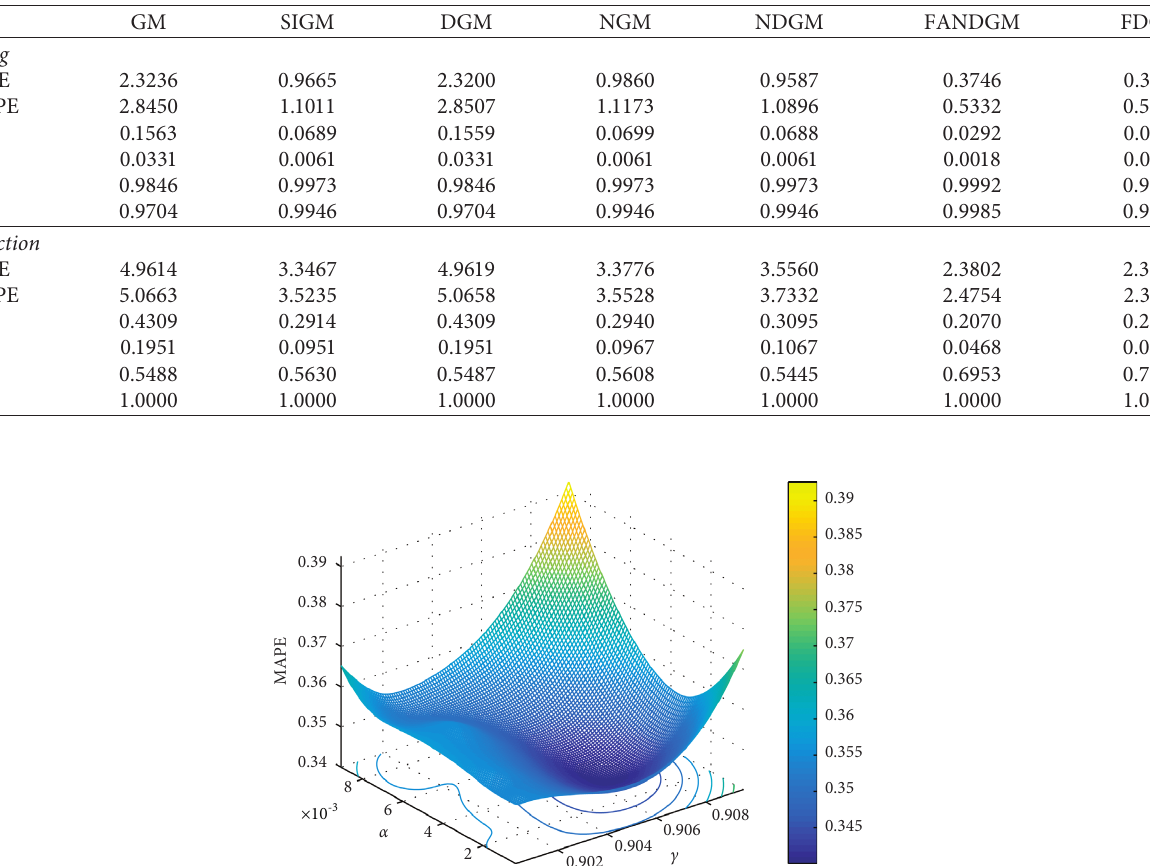
Table 3: Error metrics of total energy consumption of civil buildings.